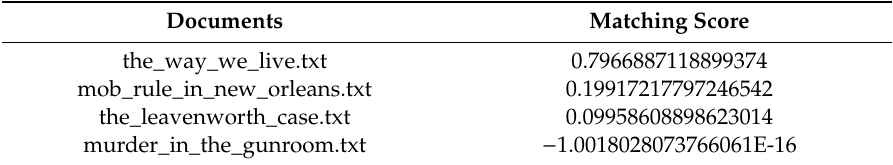
Table A8. Top Docs for TermQuery: prison, kill, and destroy.